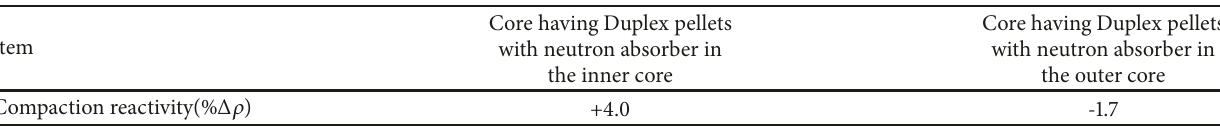
Table 2: Comparison of compaction reactivity between the core having Duplex pellets with neutron absorber in the inner and outer